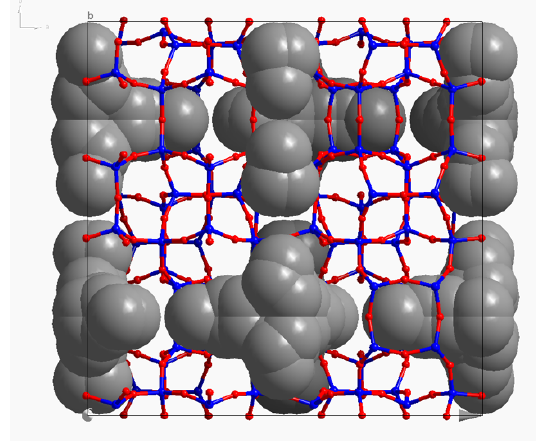
Figure 1. MFI structure containing the TPA molecules at the intersections of the channels. ZSM-5 is a medium pore size zeolite which has been assigned the three-letter code MFI by the International Zeolite Association (IZA), and its structure contains a sinusoidal channel along the a -axis that intersects with straight channels running along b with pore apertures of 5.1 × 5.5 A and 5.3 × 5.6 A, respectively [61]. The structure can be built by the linkage of four different Composite Building Units (CBUs) and contains a small cage, known as mel , which usually hosts the fluorine atoms incorporated when the synthesis is done in fluoride medium [62,63]. This zeolite can be synthesized in a wide range of chem- ical compositions and in the presence of a great variety of molecules as OSDAs or even in the absence of any organic, being the first case of an inorganic structure directing effect. Recently, we have studied the synthesis of the pure silica MFI zeolite, known as sili- calite-1, by applying the dual-template method using tetraethylammonium (TEA) and tet- raethylphosphonium (TEP) cations in which both molecules operated as co-templates and the characteristics of the zeolites were modified by changing the TEA/TEP ratio inside of their channels [64]. In this work, we extend the synthesis of silicalite-1 using tetraprop- ylammonium (TPA) and tetrapropylphosphonium (TPP) cations and mixtures thereof as OSDAs, since TPA is the most used organic molecule for the synthesis of MFI materials, and it is worth studying their preparation in the presence of TPA/TPP. Thus, the main objective of this work is the characterization of pure silica MFI zeolite (silicalite-1) prepared by the dual-template route with TPA, TPP, and mixtures of both cat- ions in different ratios aiming to understand how the nature of the organic influences the physico-chemical properties of the zeolite. This study has been carried out by exhaustive characterization of the zeolites prepared with special emphasis on the use of solid state nuclear magnetic resonance techniques which are very powerful for this purpose. In par- ticular, a multinuclear magic angle spinning-nuclear magnetic resonance (MAS NMR) analysis has allowed for investigating the framework structure, the status of the guest species located within the void volume of the zeolites, as well as the interaction between them. This MAS NMR study includes the resonance spectra of 13 C, 1 H, 31 P, 29 Si, and 19 F nuclei for the characterization of the guest species and the host zeolite, and bidimensional (2D) heteronuclear (HETCOR) and homonuclear (DQ-SQ) NMR experiments for shed- ding light on the interactions of the OSDAs with the zeolite. The results allow us to con- clude that the dual-template route with TPA/TPP for the synthesis of MFI is achievable, both organics are hosted inside the pores forming a homogeneous mixture, and the con- centration of structural defects (i.e., silanol groups) depends on the amount of P incorpo- rated in the zeolite. 2. Materials and Methods 2.1. Synthesis of Silicalite-1 Zeolites